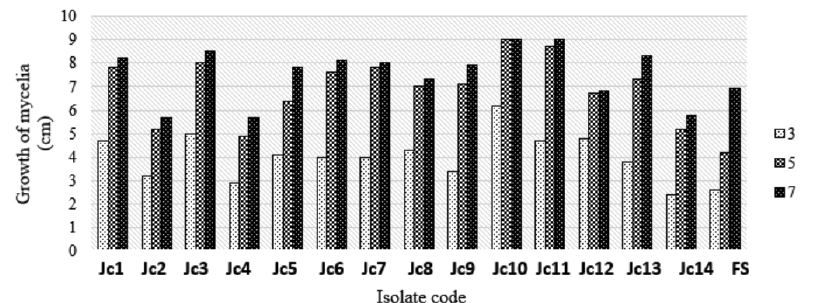
Fig. 1. Mycelia growth of Jatropha leaf Endophytes isolates ( J. curcas L.) and F. oxysporum on 3, 5, and 7 days after inoculation (DAI).